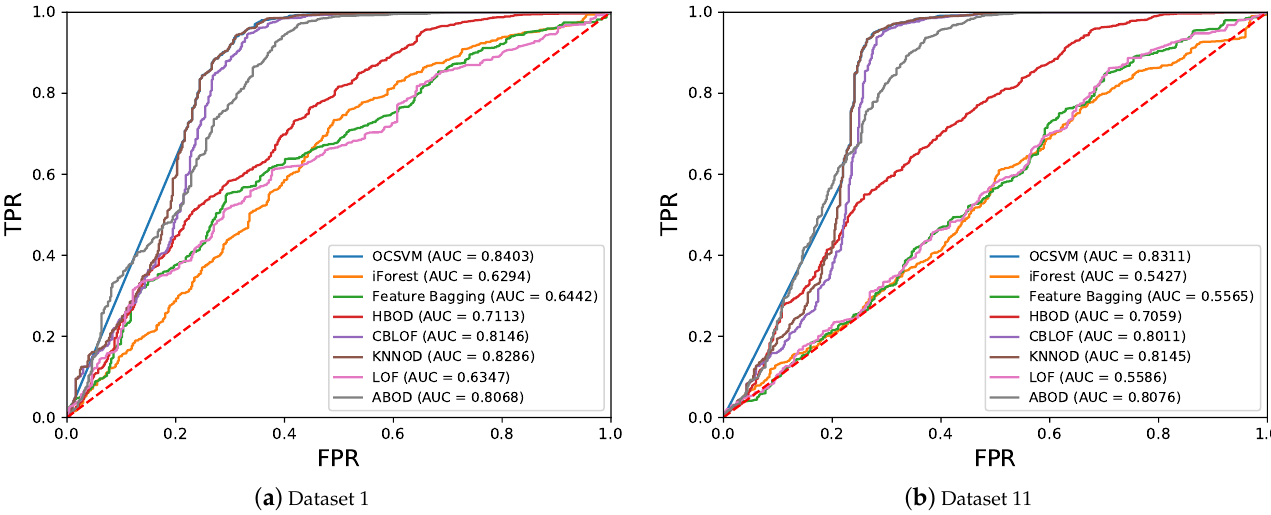
Figure 10. Examples of ROC curves obtained from semi-supervised anomaly detection algorithms using all features on datasets 1 and 11 in one run of the experiment.